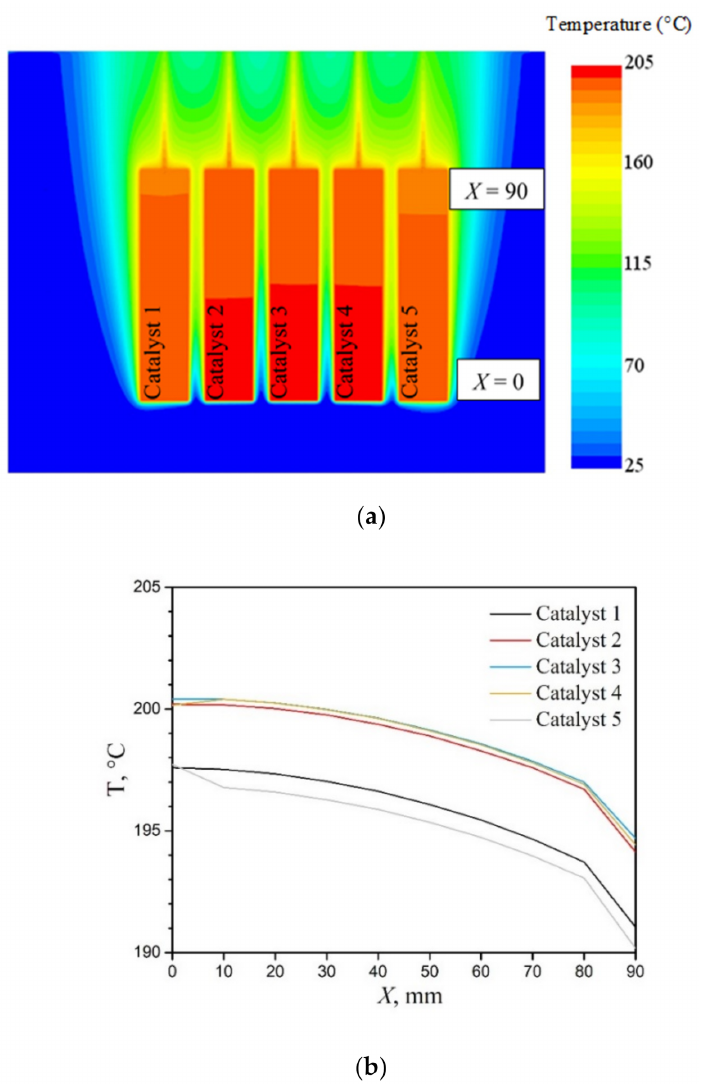
Figure 10. IR camera temperature map of Pt/AAO catalyst obtained at steady-state conditions ( a ) and the change in Pt/AAO catalyst surface temperature as a function of catalyst “position” X ( b ), determined by computational fluid dynamics (CFD)